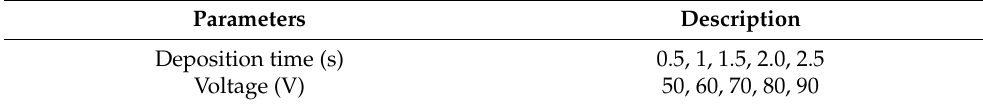
Table 5. Variable parameters and setting values of the EPD experiments.